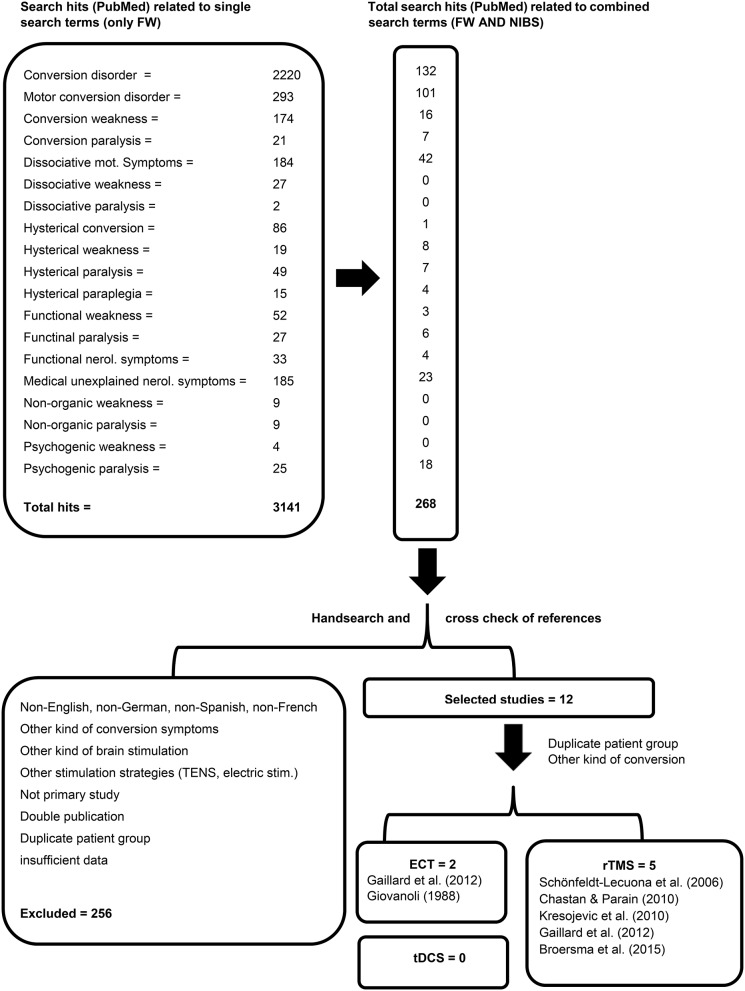
The flowchart delineates the process and the results of the literature search.